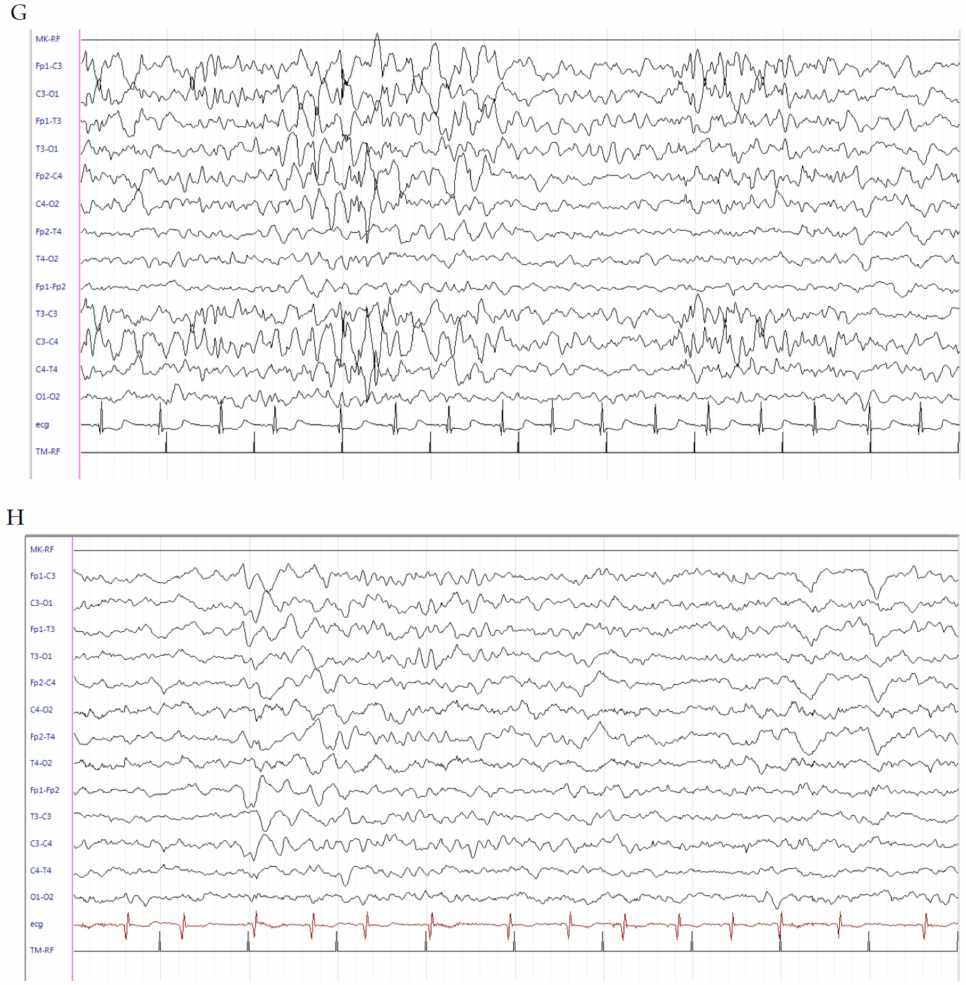
Figure 2. Electroencephalogram (EEG) of patient 2. ( A – D ) Ictal EEG shows focal slowing in the left central region, followed by appearance of medium–high-voltage, rapid, spiky activity in the left central region, suddenly generalizing. High-voltage and medium-voltage delta activity mainly in the right central region is evident at the end of the seizure. ( E , F ): Interictal EEG recording shows brief medium-voltage spike–slow wave discharges in either the left or right central regions, mostly asynchronous. ( G ): Interictal discharges consisting of prevalent isolated events of brief sharp wave–slow wave complexes turned over to the frontal lobe (left > right). ( H ): Gradual onset of trac é alternant of the